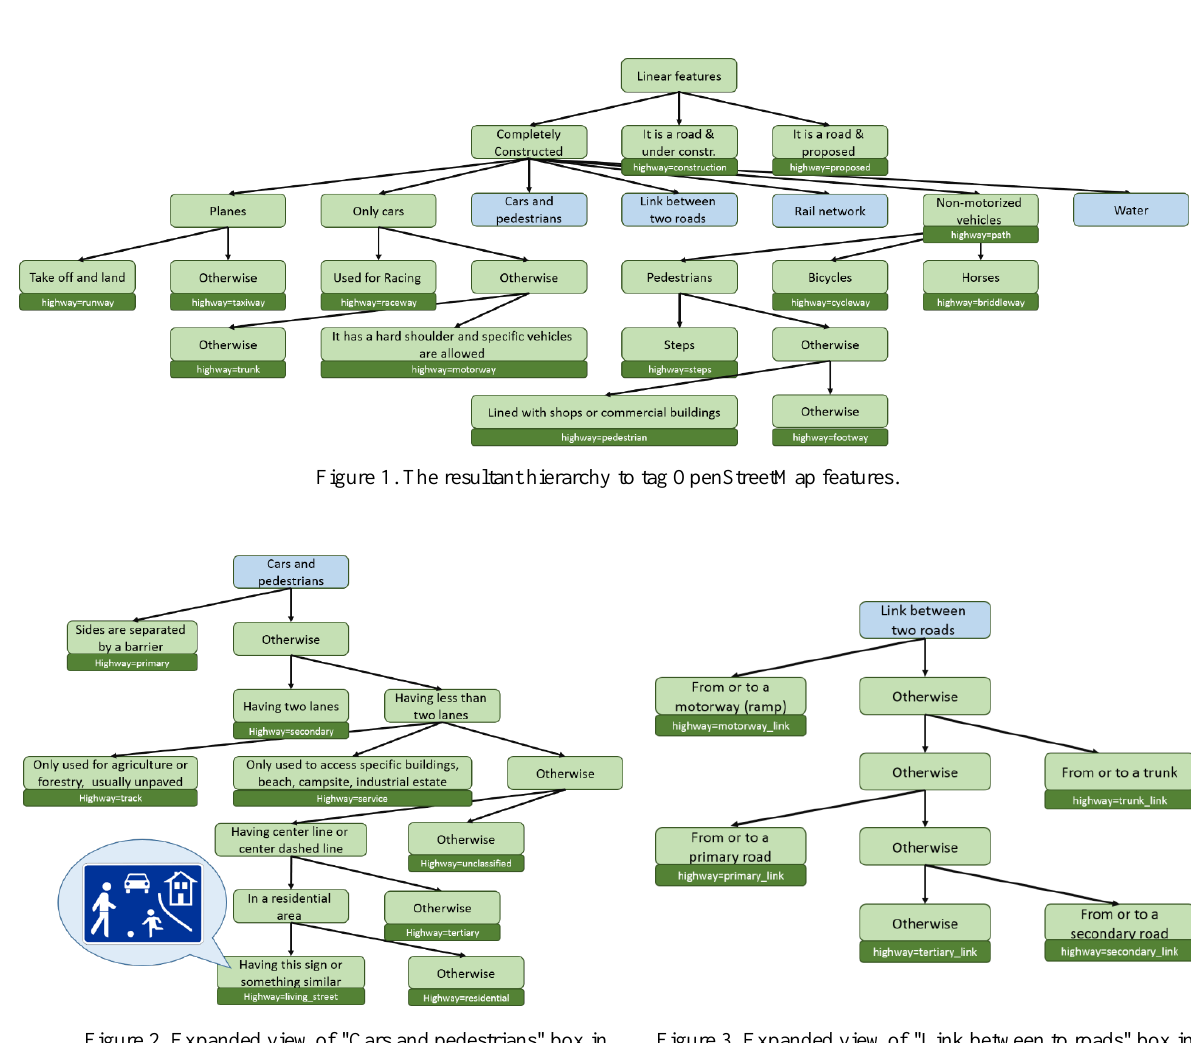
Figure 3. Expanded view of "Link between to roads" box in Figure